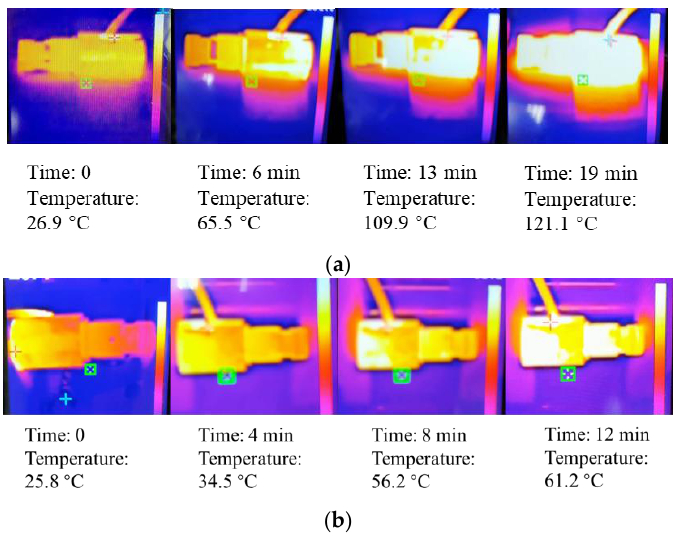
Figure 12. The temperature nephogram in two driven strategies: ( a ) The temperature nephogram in single voltage strategy at 20 Hz; ( b ) The temperature nephogram in PECA at 20 Hz.